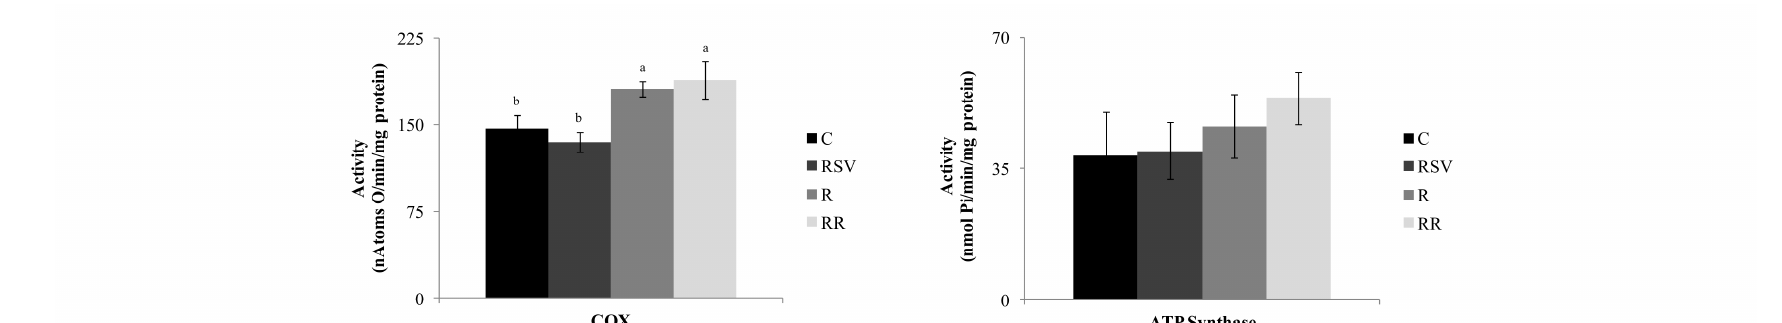
Figure 3. CPT1 and CS, SDH, COX and ATP Synthase activities in liver from rats fed an obesogenic diet for six weeks, and then fed a standard diet (C), or a standard diet supplemented with resveratrol (RSV), or submitted to energy restriction and fed a standard diet (R) or submitted to energy restriction and fed a standard diet supplemented with resveratrol (RR) ( n = 9/group) for additional six weeks. Values are mean ± SEM. Differences among groups were determined by using one-way ANOVA followed by Newman Keuls post-hoc test. Values not sharing a common letter are significantly different ( p < 0.05). CPT1a: carnitine palmitoyltransferase-1a, CS: citrate synthase, SDH: succinate dehydrogenase, COX: cytochrome c oxidase.